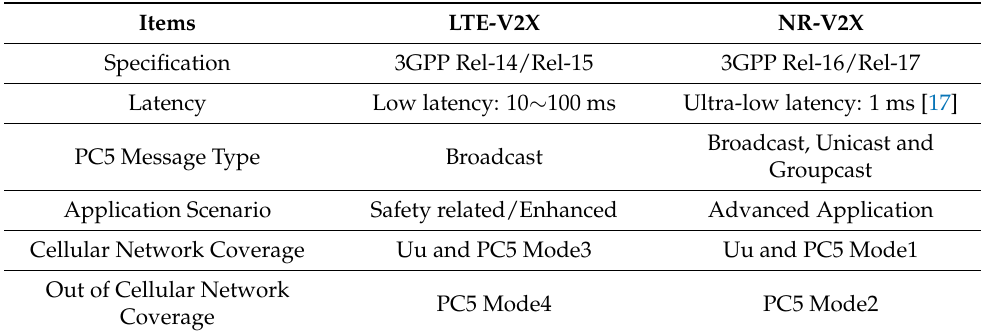
Table 1. Difference between LTE-V2X and